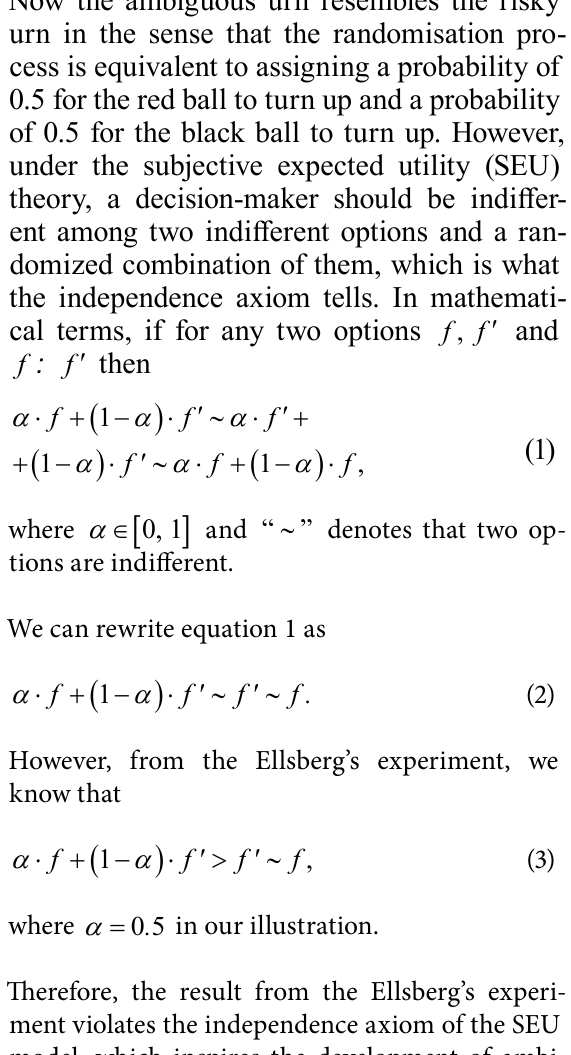
Notes: “Red” and “black” in the first row represent the outcomes of a red ball and a black ball, respectively; “bet red” and “bet black” in the first column represent the decision-maker’s decisions (also known as acts in economic terms) of betting a red ball and betting a black ball,